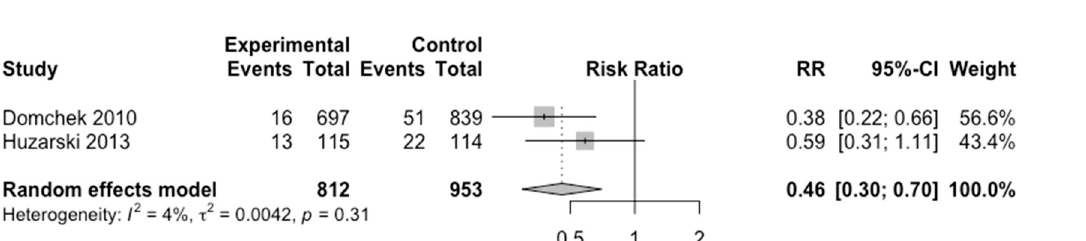
Figure 2. Forest plots of pooled relative risk estimates evaluating breast cancer endpoints following RRSO in BRCA carriers [22,58,59,62,66–69,82,89,94,97]. RRSO—risk-reducing salpingo-oophorectomy. Table 4 summarises the relative risks for all the baseline and subgroup